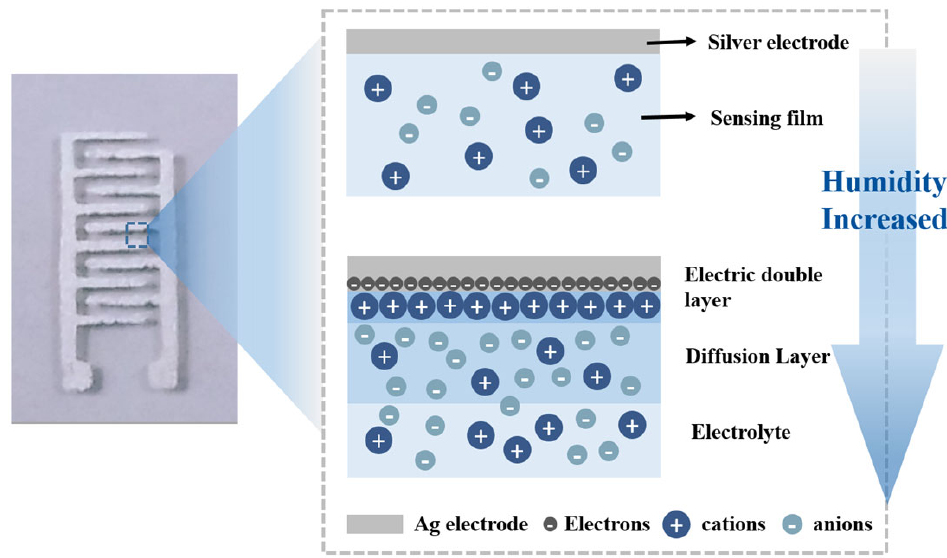
Figure 8. Schematic diagram of the humidity-sensing mechanism of cellulose-based sensors.